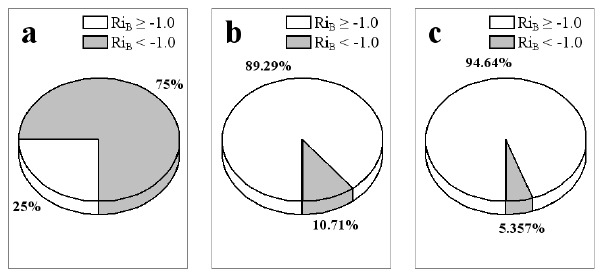
Figure 3. Percentage share of the unstable (represented by Fig. 3. Percentage share of the unstable (represented by Ri B < − 1 . 0 ) and near-neutral or stable atmosphere ( Ri B ≥− 1 . 0 )databasefor a clear-sky, b cloudy butnon-precipitating,and c rainydays. Ri B < − 1.0) and near-neutral or stable atmosphere ( Ri B ≥ − 1 . 0) database for (a) clear-sky, (b) cloudy but non-precipitating, and (c) rainy